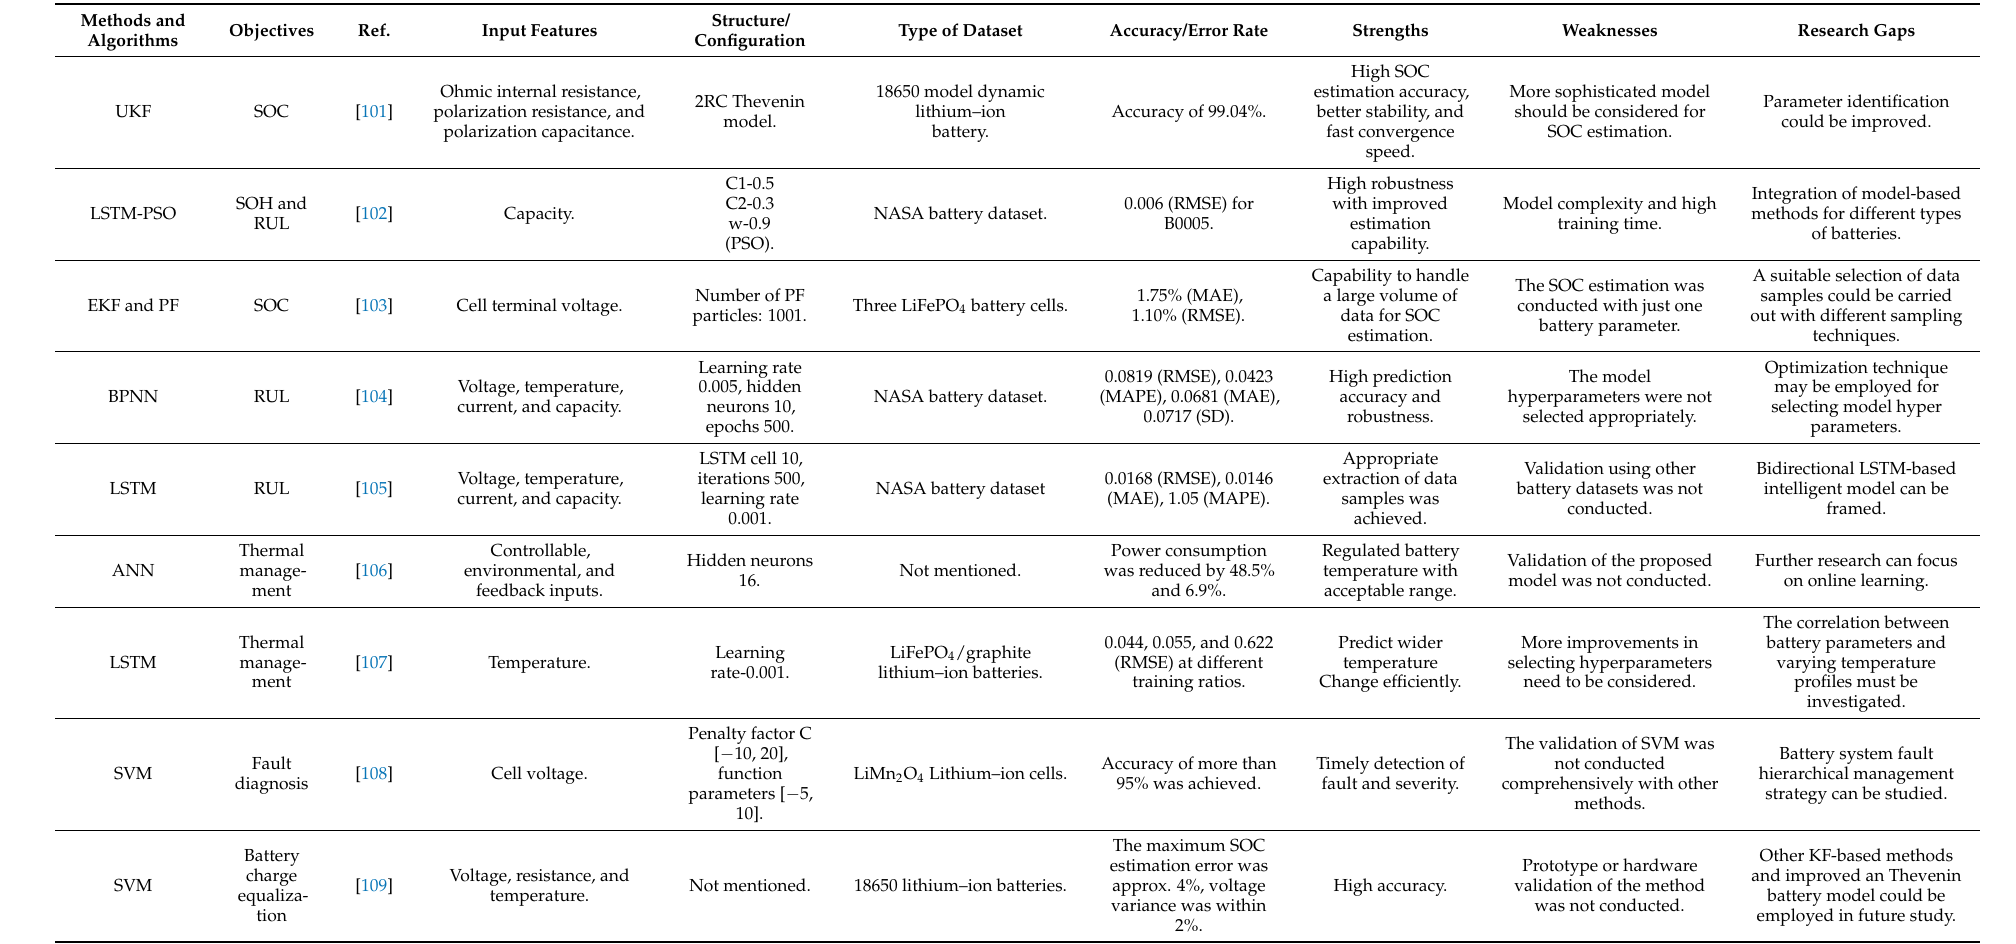
Table 5. State-of-the-art methods and algorithms for BMS in